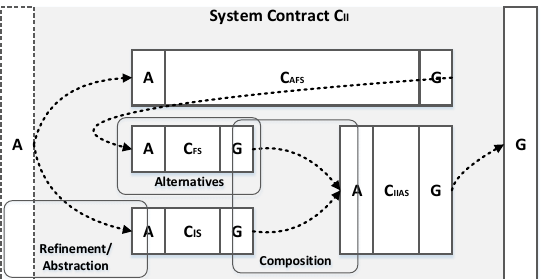
Fig. 4. The Engine Controller system represented using contracts and their basic relations (A – assumptions, G – guarantees, C –